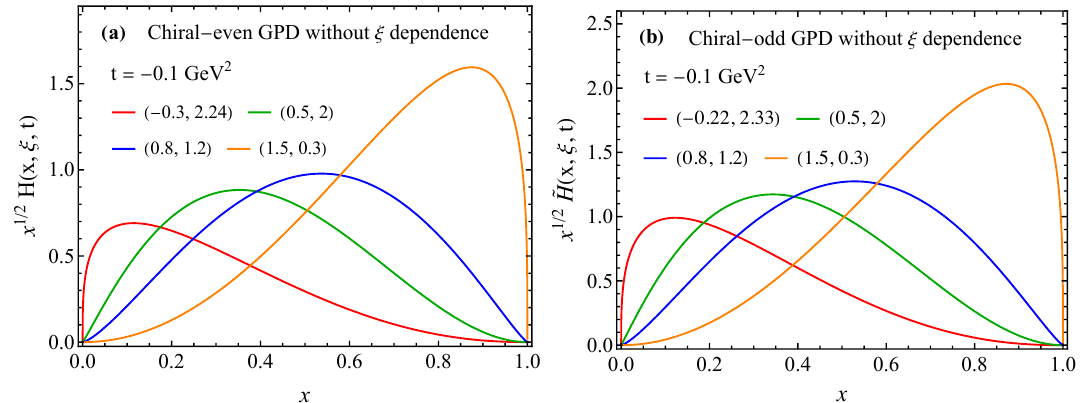
Figure 22. Chiral-even GPD H ( x, ξ, t ) (a) and chiral-odd GPD e H ( x, ξ, t ) (b) for t = − 0 . 1 GeV 2 and different power parameters ( ρ, τ )